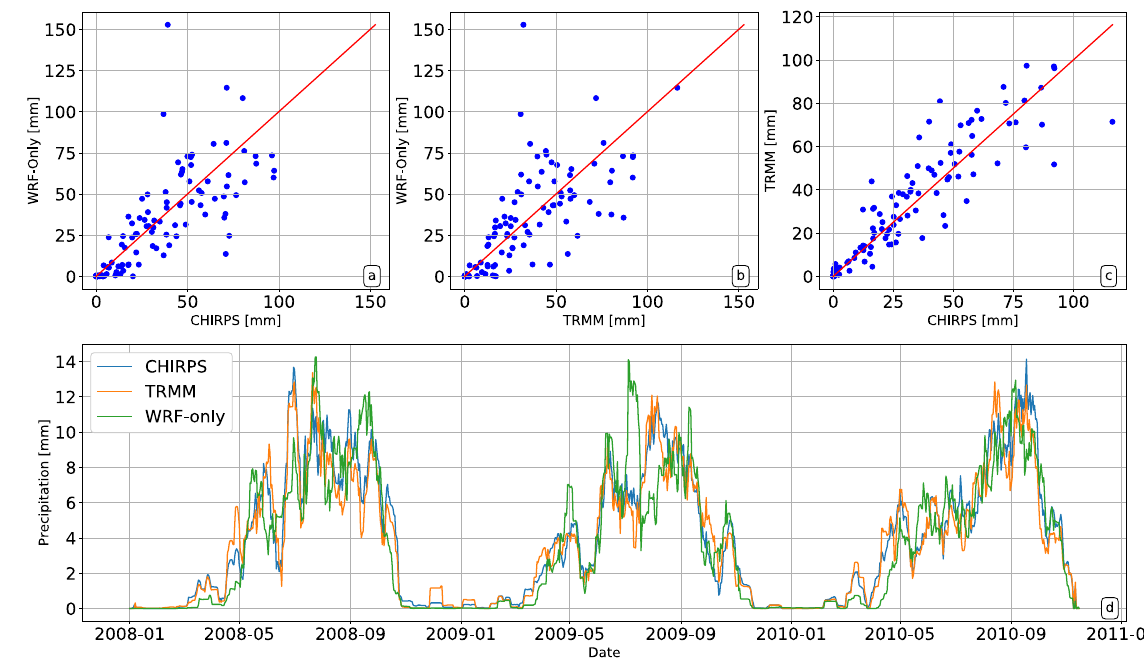
Figure 2. Scatter plots of simulated WRF-only vs. observed ( a ) the Climate Hazards Group Infrared Precipitation with Stations (CHIRPS), and ( b ) the Tropical Rainfall Measuring Mission (TRMM) weekly cumulative precipitation for period 2008–2010, ( c ) comparison between observed, and ( d ) analysis of seven-day filtered daily precipitation for WRF-only, CHIRPS, and TRMM.